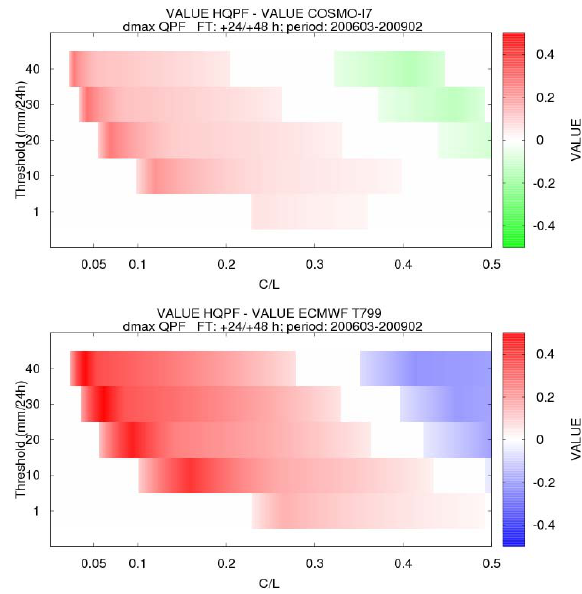
Fig. 5. Maps of the Value differences between HQPF and, respec- tively, COSMO-I7 (top) and IFS (bottom), for different thresholds and different C/L ratios, considering QPFM and the forecast time +24h/+48h. Note that only when the difference between HQPF Value and model QPF Value is statistically significant this differ- ence is plotted. The bar indicates that when there are positive values (red colour), HQPF has more Value than the